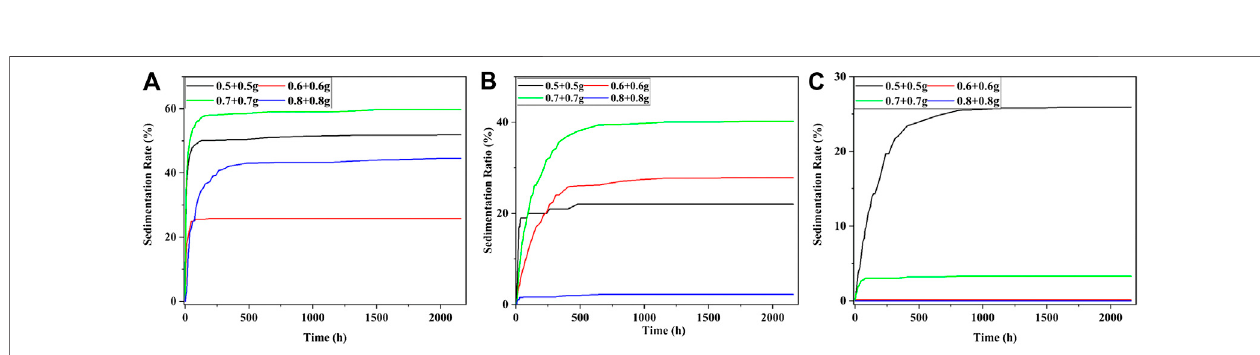
FIGURE 9 | The settling rate when the surfactant was mixture; the mass fraction of CI was (A) 40%, (B) 50%, and (C) 60%.